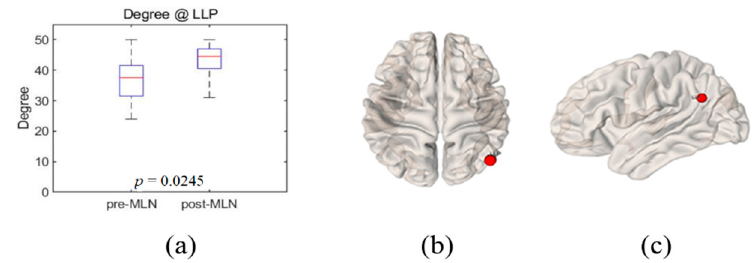
Figure 1. Illustrations of the degree of change in functional connectivity of neural network at the left lateral parietal cortex in fibromyalgia (FM) patients due to milnacipran (MLN) drug therapy. ( a ) Boxplots (left: before medication, right: after medication) of the degree distribution at the left lateral parietal cortex. This position is indicated by red circular markers on the 3D brain surface in ( b ) transverse and ( c ) lateral views. Red color markers imply that the degree index statistically increased due to drug therapy.